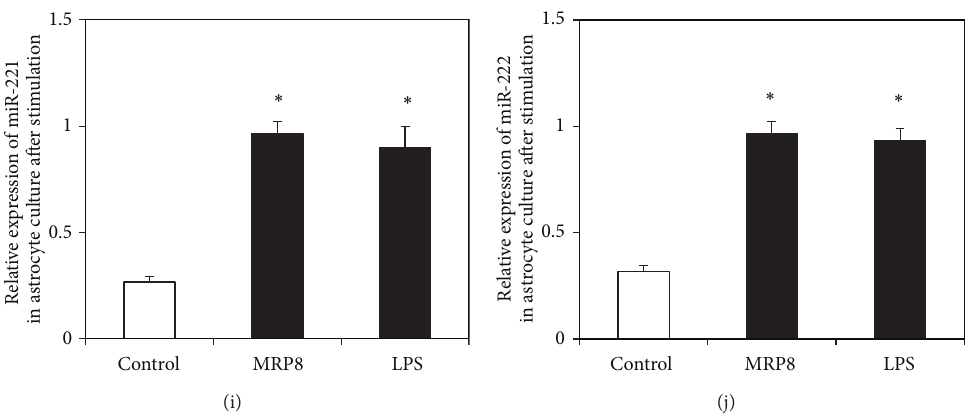
Figure 1: ((a), (b), (c), (d), (f), (g), (h), (i), (j)) qPCR results showed significant upregulation of miRNAs (124, 134, 9, 132, 146a, 21, 181a, 221, and 222) in the astrocytes after stimulation with MRP8 and LPS, while miRNA-138 was significantly downregulated in the astrocytes after stimulation with MRP8 and LPS (e).